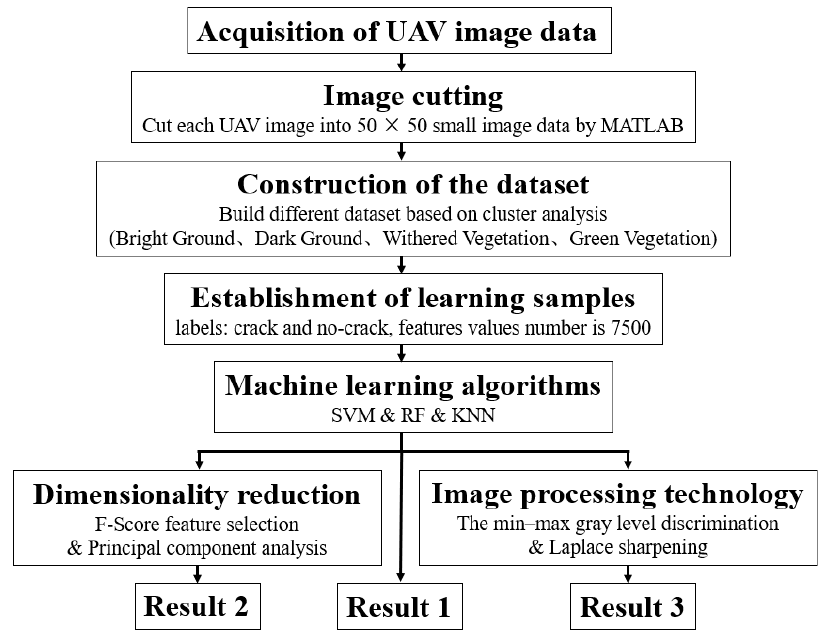
Figure 6. Flowchart of a new identification method for surface cracks from UAV images based on machine learning in coal mining areas.